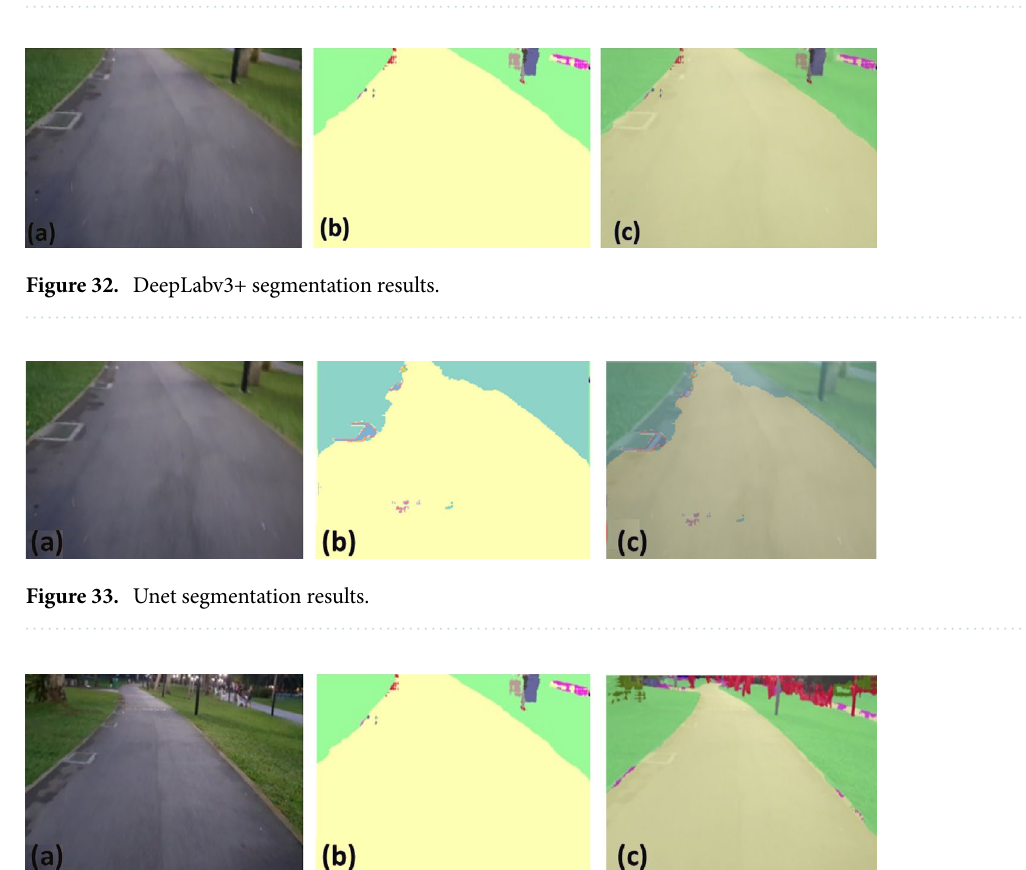
Figure 31. Surface plot for output speed safety factor.